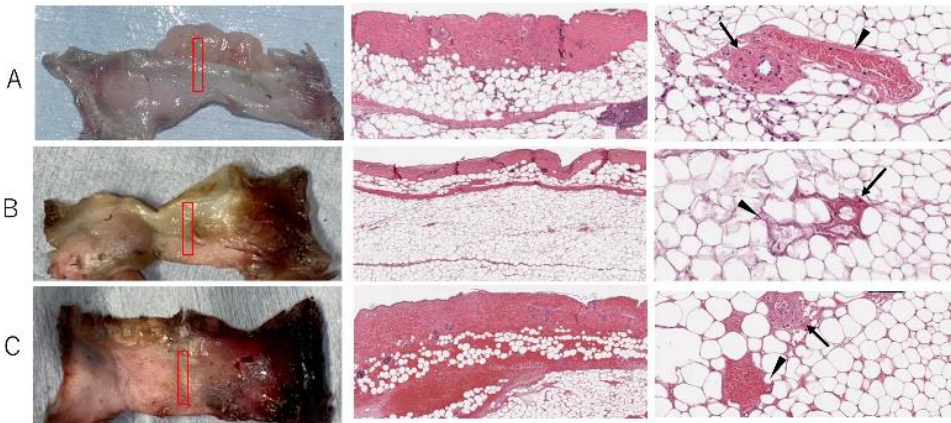
Figure 7. Histological findings of ( A ) control, ( B ) ischemic, and ( C ) congestive lymph nodes (LNs). Black arrows in hematoxylin and eosin stain indicate hilar sites: ( A ) The control LNs maintained their internal structure. ( B ) In ischemic LNs, intravascular thrombus and intravascular fibrin deposition were observed in the medulla. ( C ) In congestive LNs, erythrocyte agglutination and fibrin deposition were observed in vascular areas near the hilum and in the marginal sinus. Moreover, inflammatory cells were observed around the clot in the marginal sinus. HE, hematoxylin and eosin; EVG, Elastica van Gieson; MT, Masson’s trichrome; PTAH, Phosphotungstic acid hematoxylin.